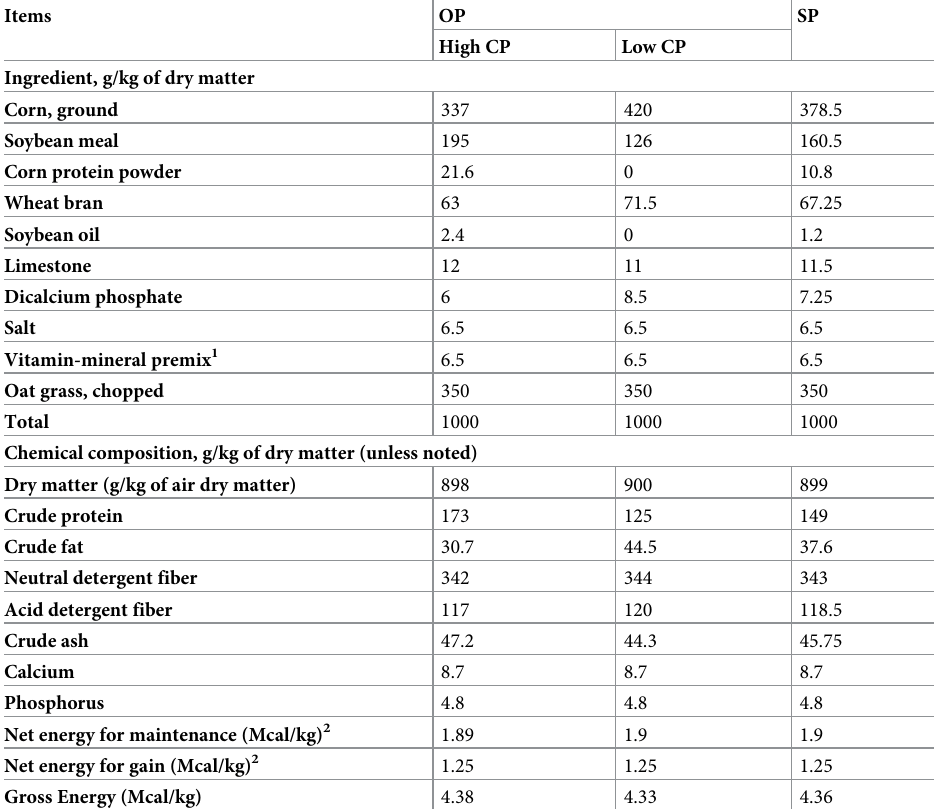
Table 1. Ingredients and nutrient composition of diets.